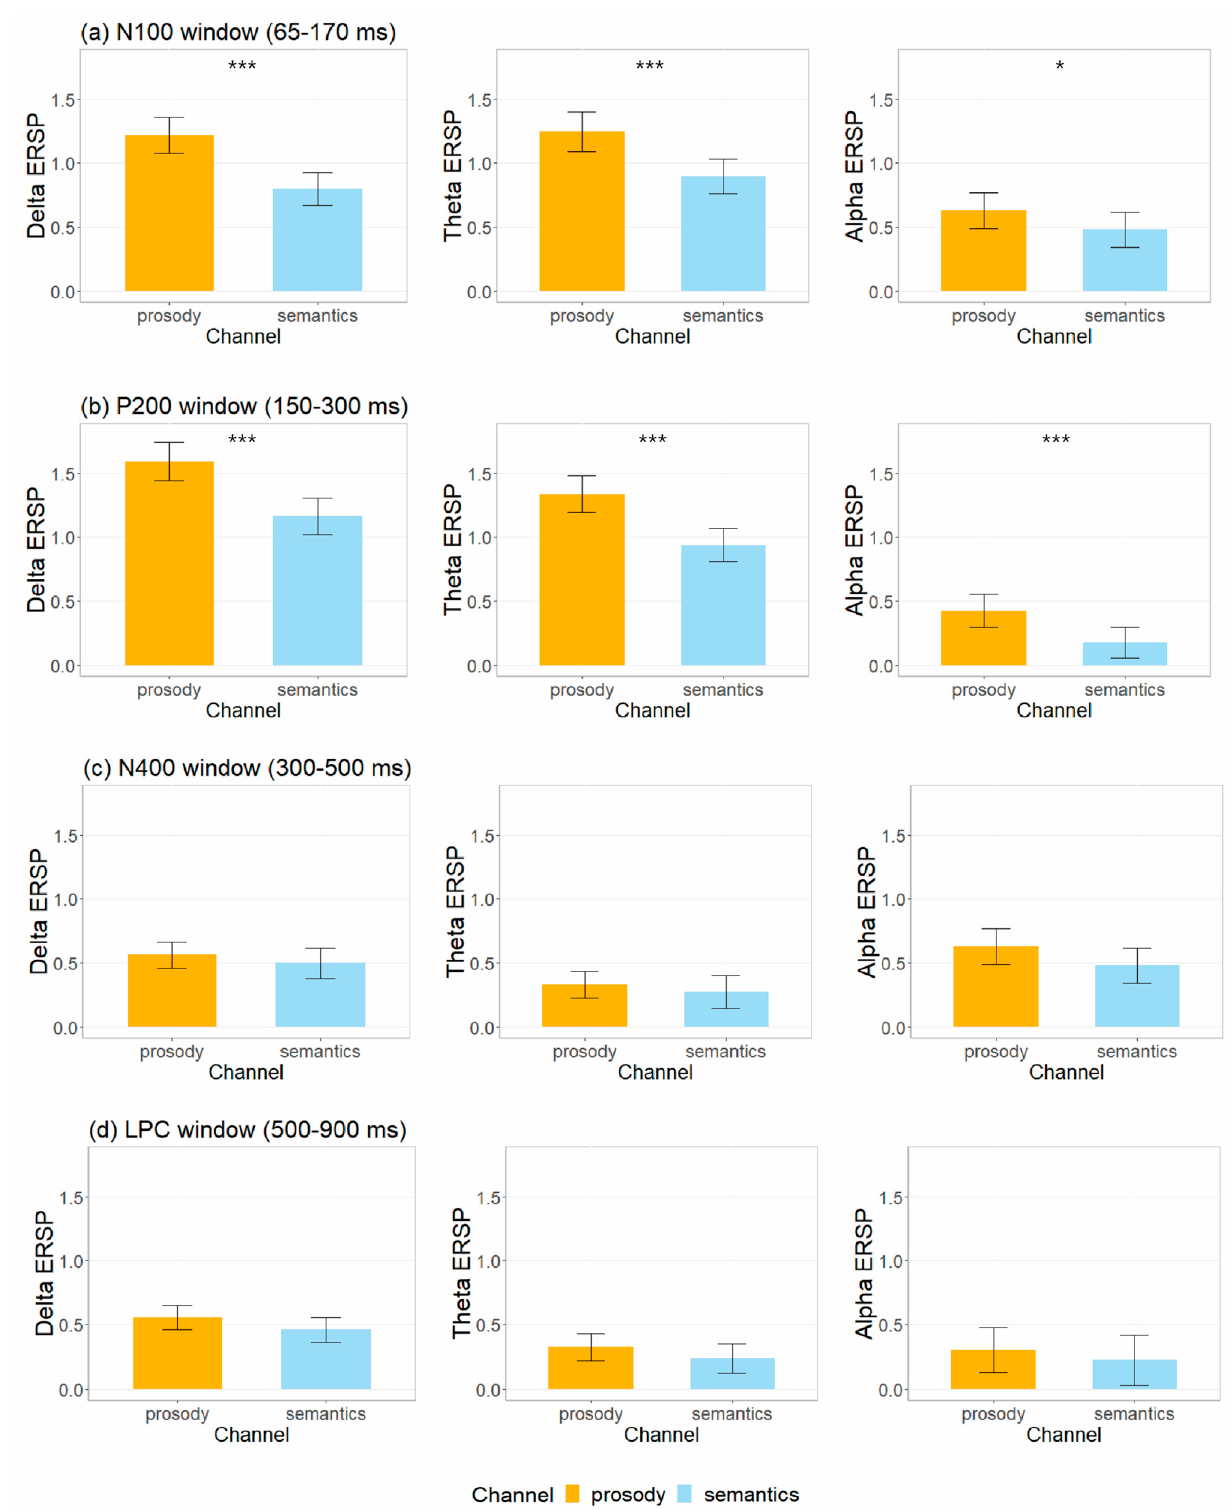
Figure 7. Bar plots of delta, theta and alpha ERSP associated with ( a ) N100, ( b ) P200, ( c ) N400 and ( d ) LPC for prosodic and semantic channels. Mean ERSP values are displayed in the bar charts with error bars showing 95% confidence intervals. Asterisks mark the significance level: * p < 0.05; ** p < 0.01; *** p < 0.001.